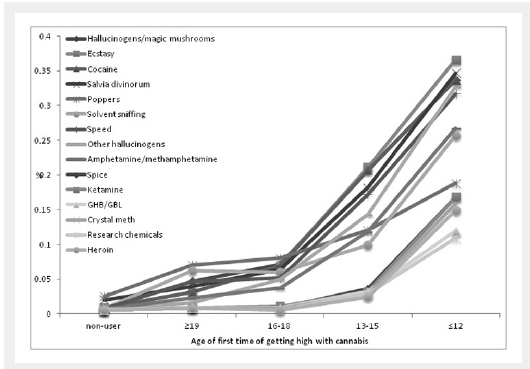
Prevalence rates of drug use according to age of first getting high with cannabis. The prevalence rate for each drug is given according to the age of first getting high with cannabis. For example, 14.9% of the participants who first got high with cannabis at age 12 years or earlier used heroin, whereas only 2.4% of the participants who first got high with cannabis at age 13 to 15 used heroin (percentages can be found in table